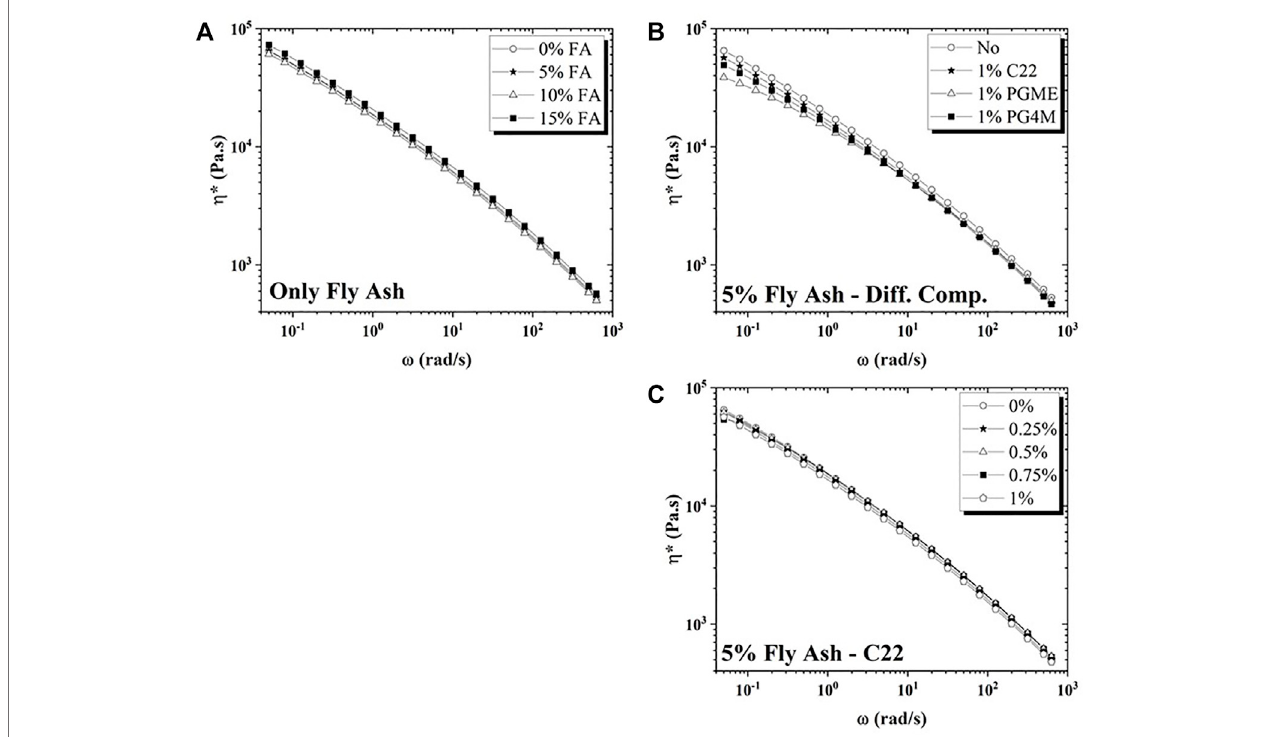
FIGURE9| Complexviscosityplotsof (A) PCRLLDPEwithdifferentconcentrationsofFA, (B) PCRLLDPEwith5 wt.%FAand1 wt.%ofthethreecompatibilizers tested (C) PCR LLDPE with 5 wt. % FA and different concentrations of the C22 compatibilizer.